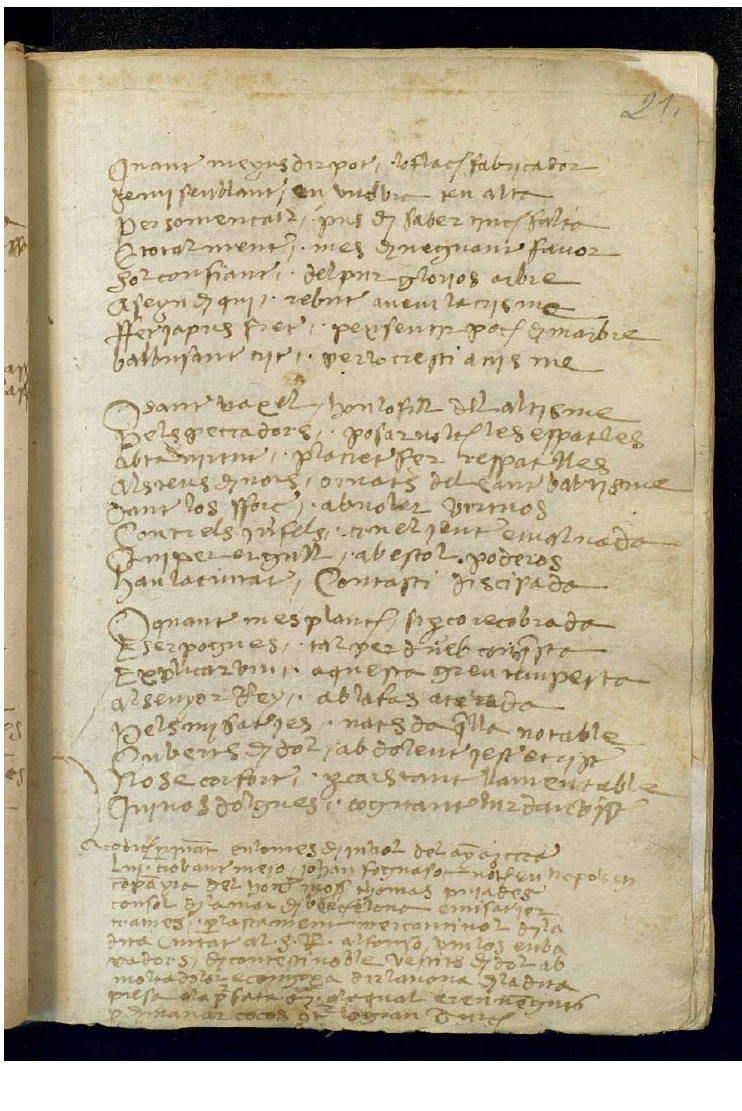
Fig. 5: Barcelona, Biblioteca de l’Ateneu Barcelonès, ms. 1, fol. 21r. Font: Biblioteca de l’Ateneu